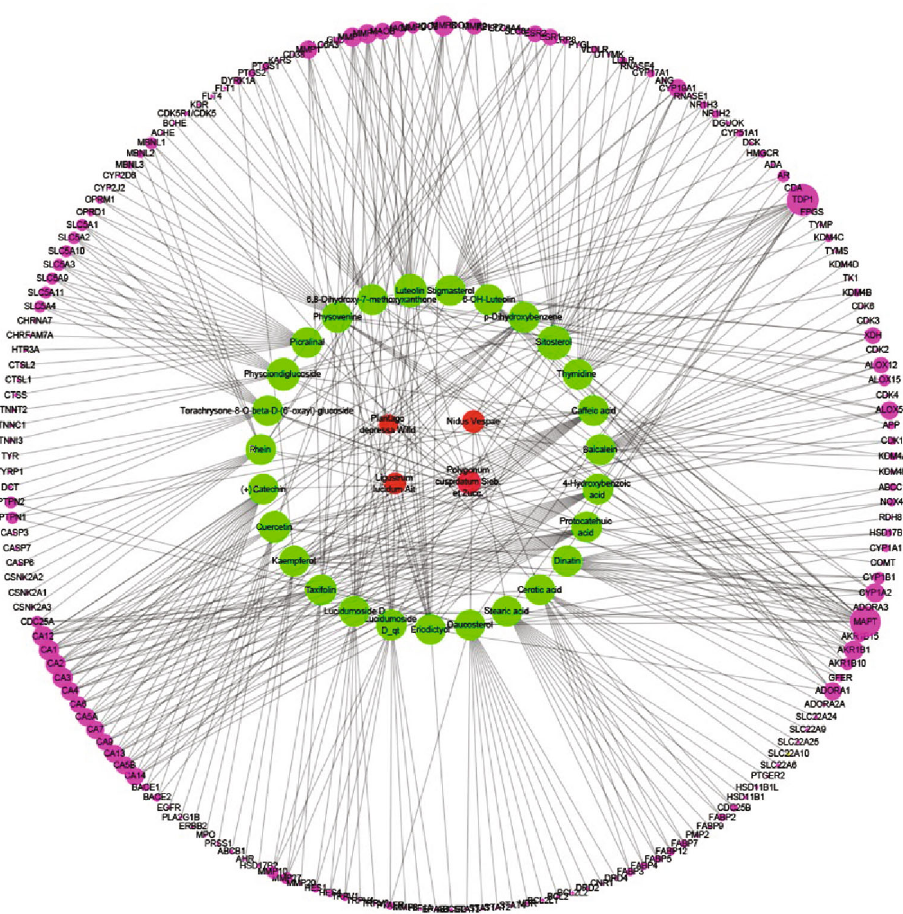
Figure 2: The compound – compound target network. Red, green, and purple circles represented the herbs composing HZTF, active compounds from the herbs, and targets of the compounds, respectively. The size of purple circles represented node degree